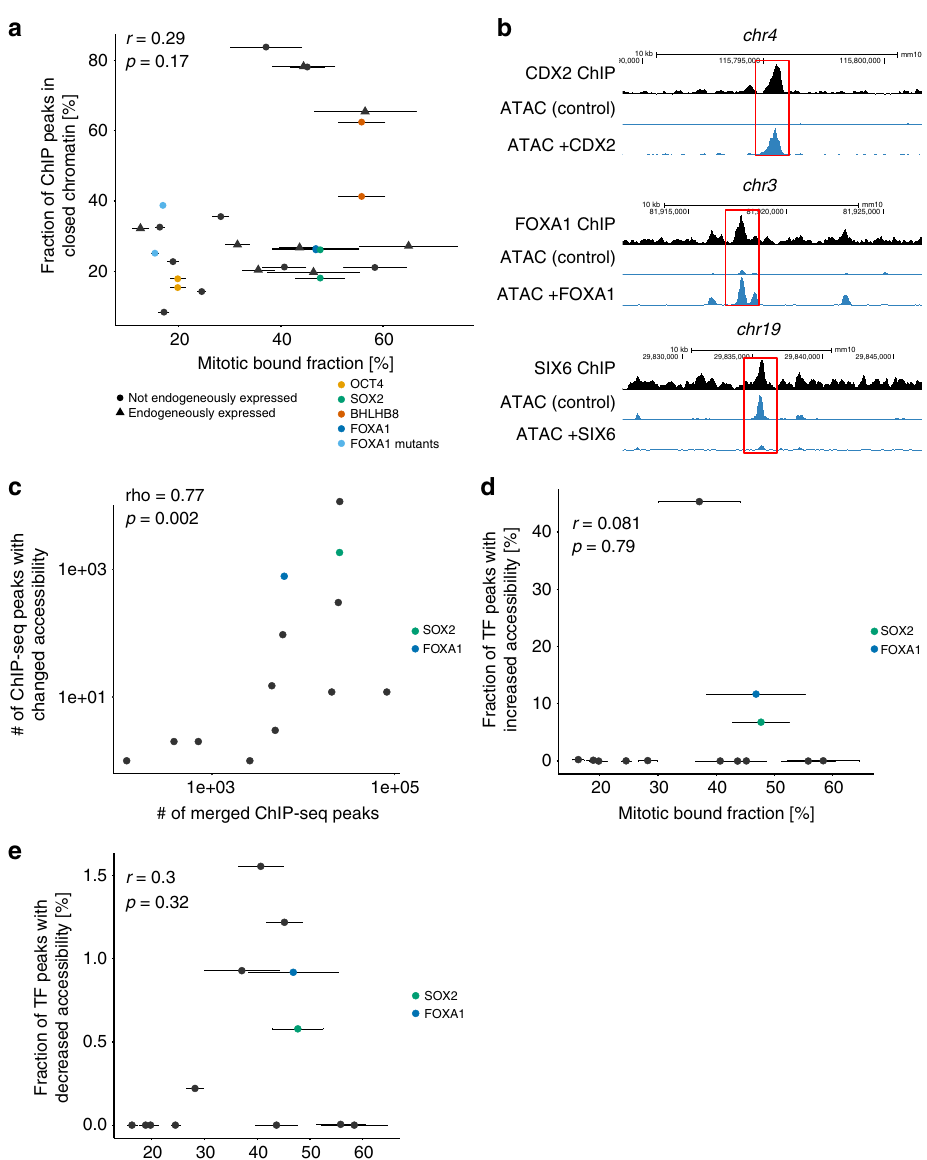
Fig. 5 TF impact on chromatin accessibility as a function of occupancy and MBF. a Correlation between the mitotic bound fraction and the fraction of peaks in closed chromatin regions (devoid of ATAC-seq signal). Duplicates are indicated for OCT4 (yellow), SOX2 (green), BHLHB8 (red), and FOXA1 (dark blue). The two FOXA1 mutants are shown in light blue. Triangles: TFs endogenously expressed in NIH-3T3. Circles: TFs not endogenously expressed in NIH-3T3. r -value ( r ) and p -value ( p ) are based on Pearson correlation. b Example tracks of ChIP-seq signal, ATAC-seq signal in control cells, and ATAC- seq signal in TF overexpression cells for CDX2, FOXA1, and SIX6 for three regions with increased or decreased accessibility after TF overexpression (highlighted in red). The y-axis is scaled equally for ATAC-seq signal in control and TF overexpression within each region. c Correlation between the number of ChIP-seq peaks for each TF and the number of TF ChIP-seq peaks with signi fi cant change of chromatin accessibility upon overexpression of the TF. Known pioneers are indicated in green (SOX2) and blue (FOXA1). Rho-value (Rho) and p -value ( p ) are based on Spearman ’ s rank correlation. d Correlation between the mitotic bound fraction and the fraction of regions overlapping a ChIP-seq peak and displaying signi fi cant increase in their accessibility upon overexpression of the TF. Same color-coding as c . r -value ( r ) and p -value ( p ) are based on Pearson correlation. e Correlation between the mitotic bound fraction and the fraction of regions overlapping a ChIP-seq peak and displaying signi fi cant decrease in their accessibility upon overexpression of the TF. Same color-coding as c . Rho-value (Rho) and p -value ( p ) are based on Spearman ’ s rank correlation. Error bars: